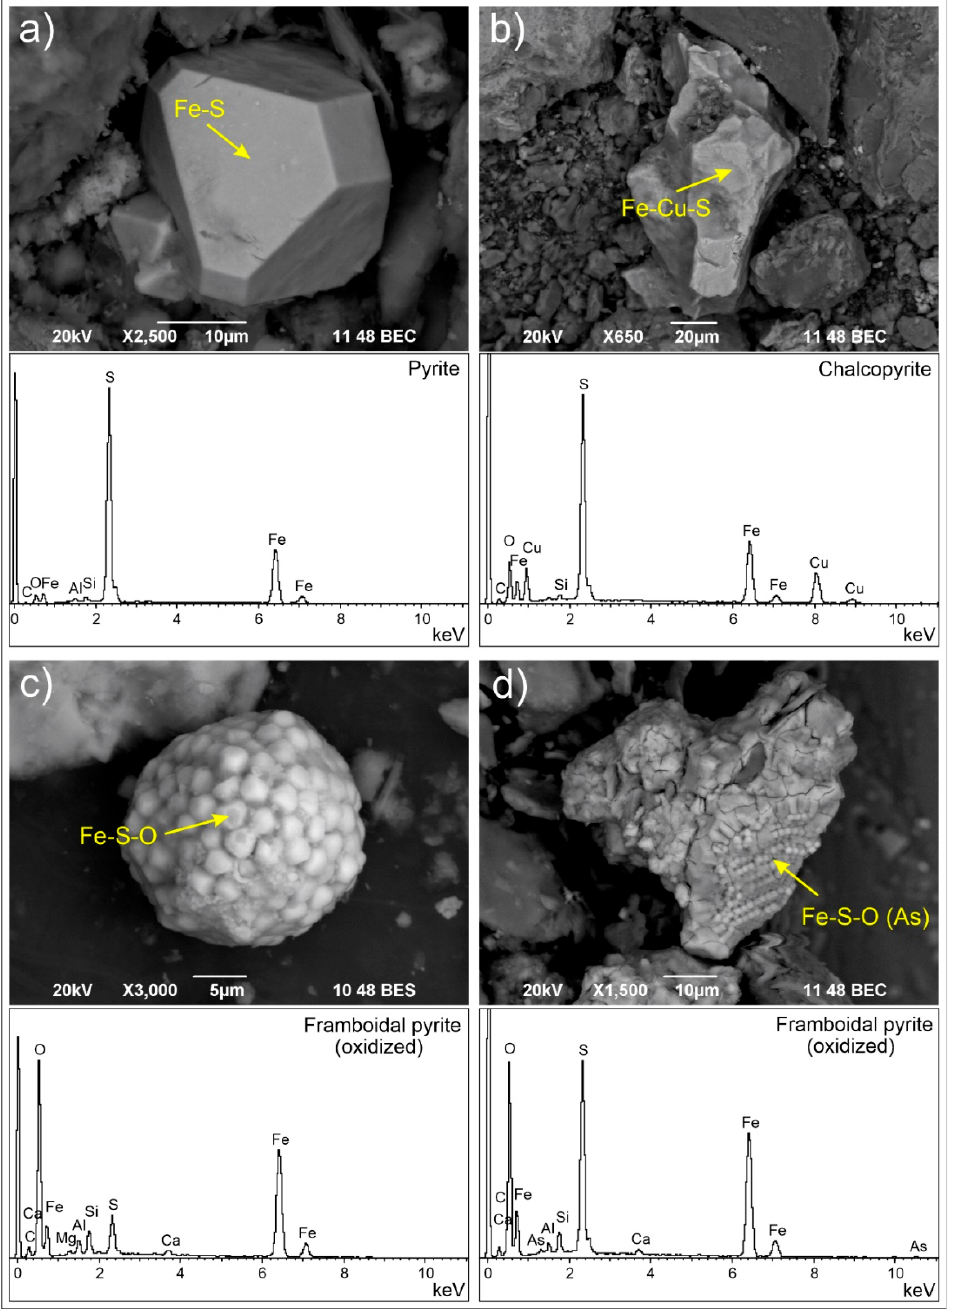
Figure 3. SEM(BSE) images and EDS spectra of solid Fe carriers in stream sediment and mine waste: ( a ) truncated pyrite octahedron; ( b ) anhedral, angular chalcopyrite; ( c ) oxidized framboidal pyrite and ( d ) oxidized framboidal pyrite with low As content showing shrinkage cracks.